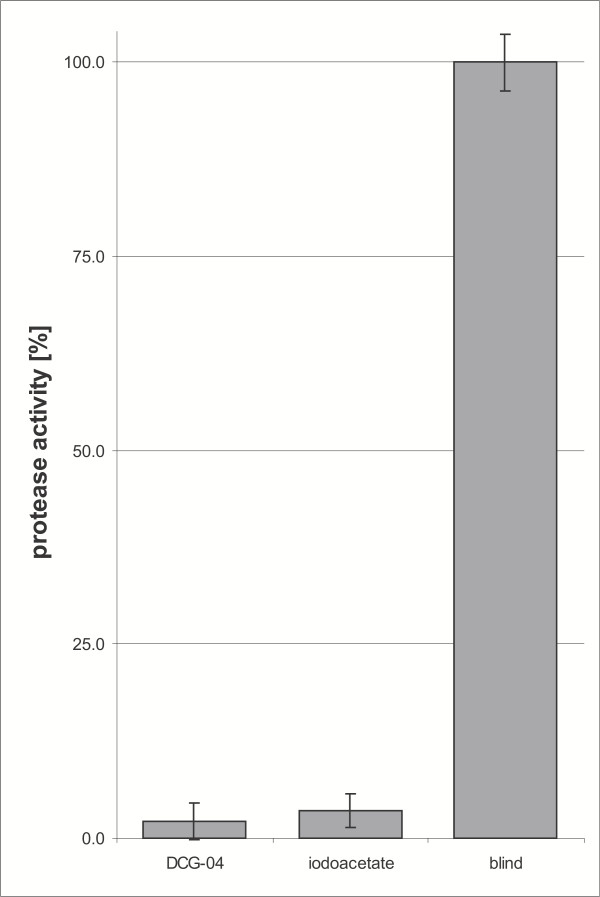
Inhibition of protease activity by DCG-04. Nearly all protease activity is inhibited by the addition of DCG-04 (first bar) compared to blind probe (water, very right bar). The inhibition by DCG-04 is comparable to all alkylated enzymes by iodoacetate (middle bar). Error bars represent standard errors of three independent experiments.